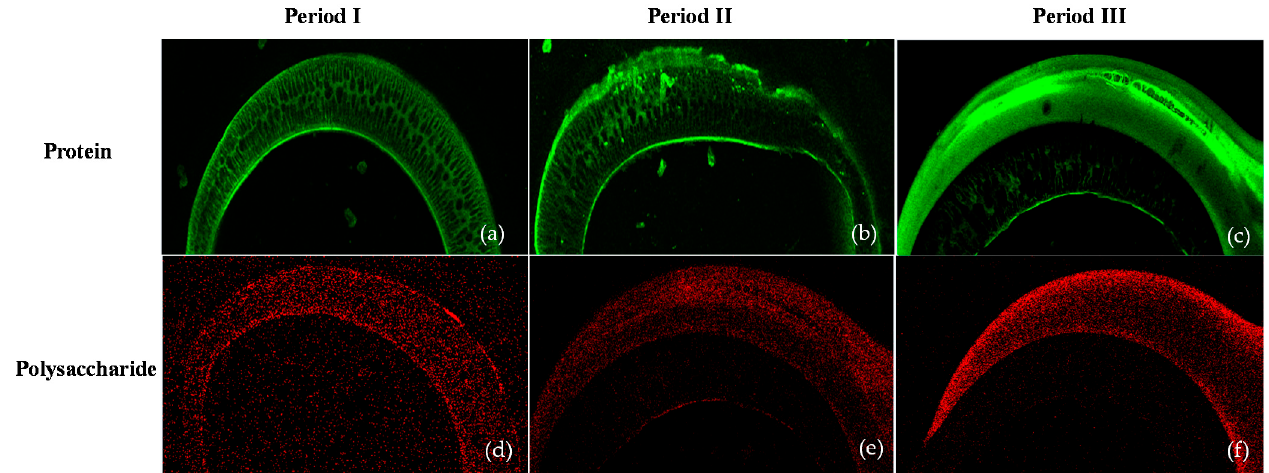
Figure 4. CLSM images of cake layer in AnMBR: period I ( a , d ), period II ( b , e ), and period III ( c , f ). FTIR